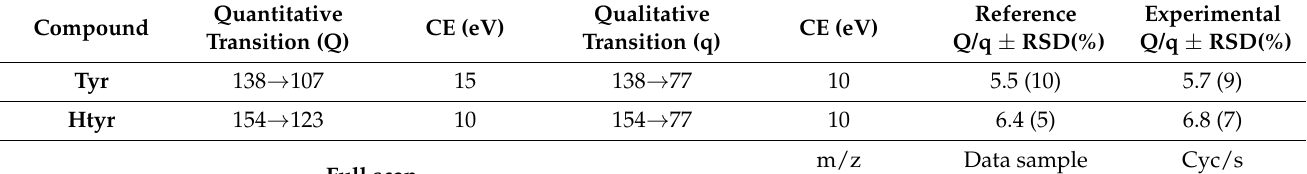
Table 1. Full scan, MS/MS parameters, and Q/q ratios (reference and experimental) of the selected phenolic compounds. Q/q ratios were calculated as the average of five injections at five calibration levels (three replicates each); relative standard deviation for solvent (Reference) and diluted EVOO samples (Experimental) are reported in parentheses.